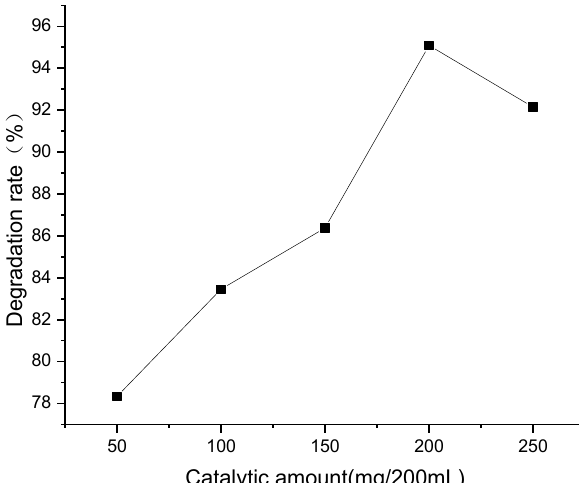
Figure 5. Degradation results of MB synthetic wastewater treated with different amounts of composite photocatalyst added.